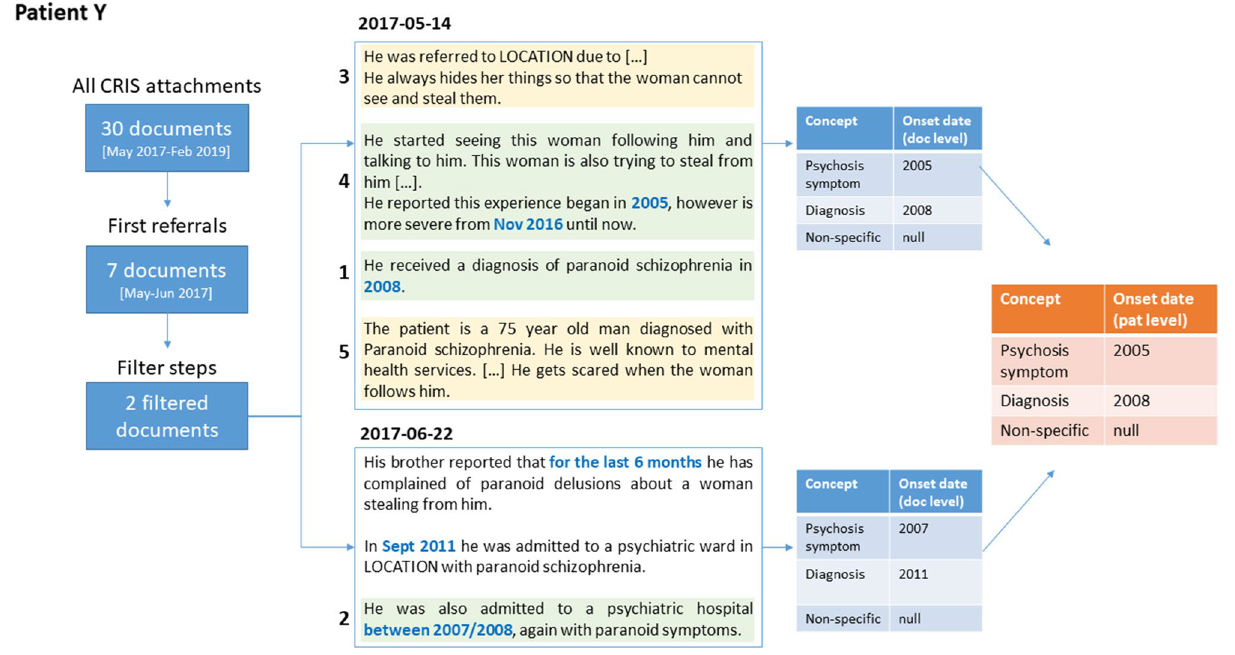
Figure 5. Data extraction and annotation for one fictitious patient. First referral documents are extracted from CRIS and filtered according to length, temporal expression count and symptom count (left). Documents are then annotated for relevant onset mentions, with types ‘psychosis symptom’, ‘diagnosis’ or ‘non-specific’ (center). In the adjudication phase, an onset date is selected per each type, first at the document level and then at the patient level (right). Paragraphs identified by the NLP classifier are marked in green (true positives) or yellow (false positives): the reported number represents their